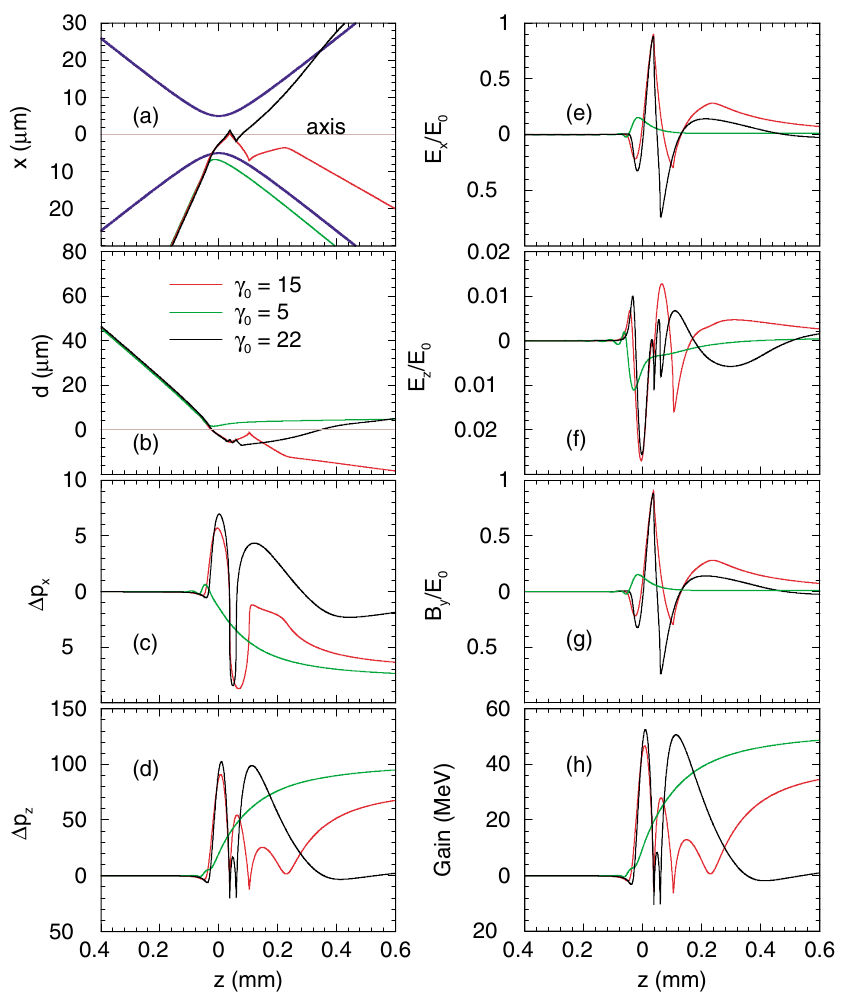
FIG. 6. (Color) Examples illustrating the cases of reflection (green), capture (red), and transmission (black). Only a small region around the beam focus is shown in each case. (a) The trajectories. (b) The quantity d defined by Eq. (22). (c) The electron x momentum transfer (cid:3) (cid:15)(cid:11) (cid:2) (cid:15) (cid:11) . (d) The electron z momentum transfer (cid:24) p sin (cid:6) (cid:24) p x x i 0 0